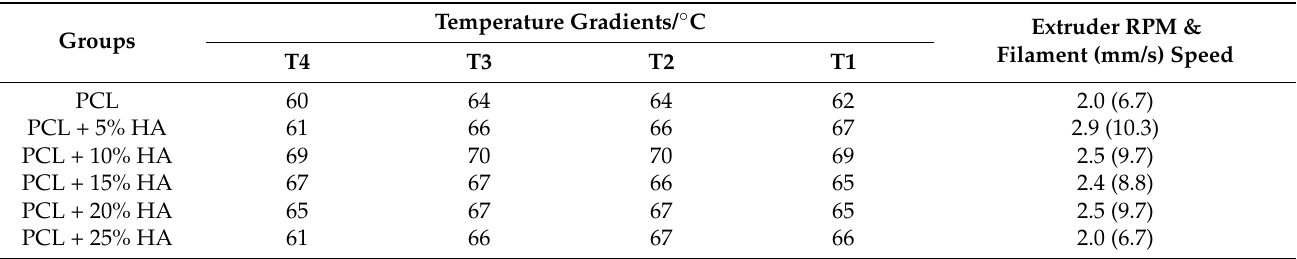
Table 1. Parameters of the filament fabrication.